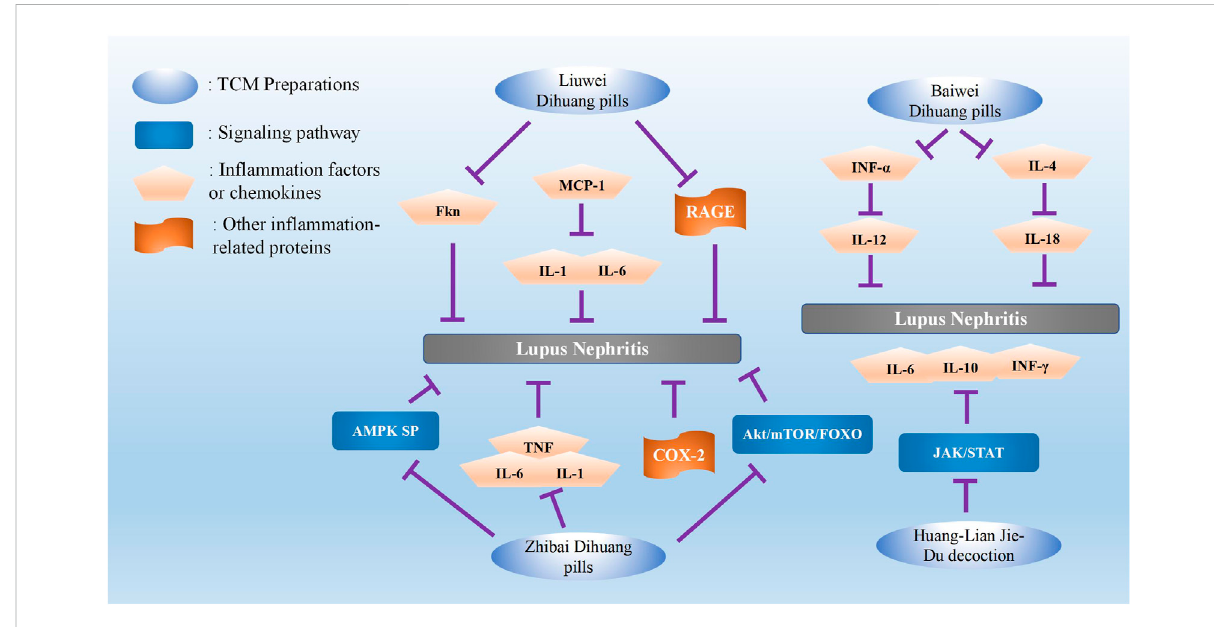
Summary of the role of TCM Preparations in the treatment of lupus